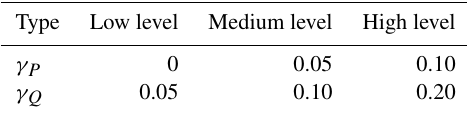
Table 3. Proportional factors of the standard deviations for precipi- tation ( γ P ) and runoff ( γ Q )